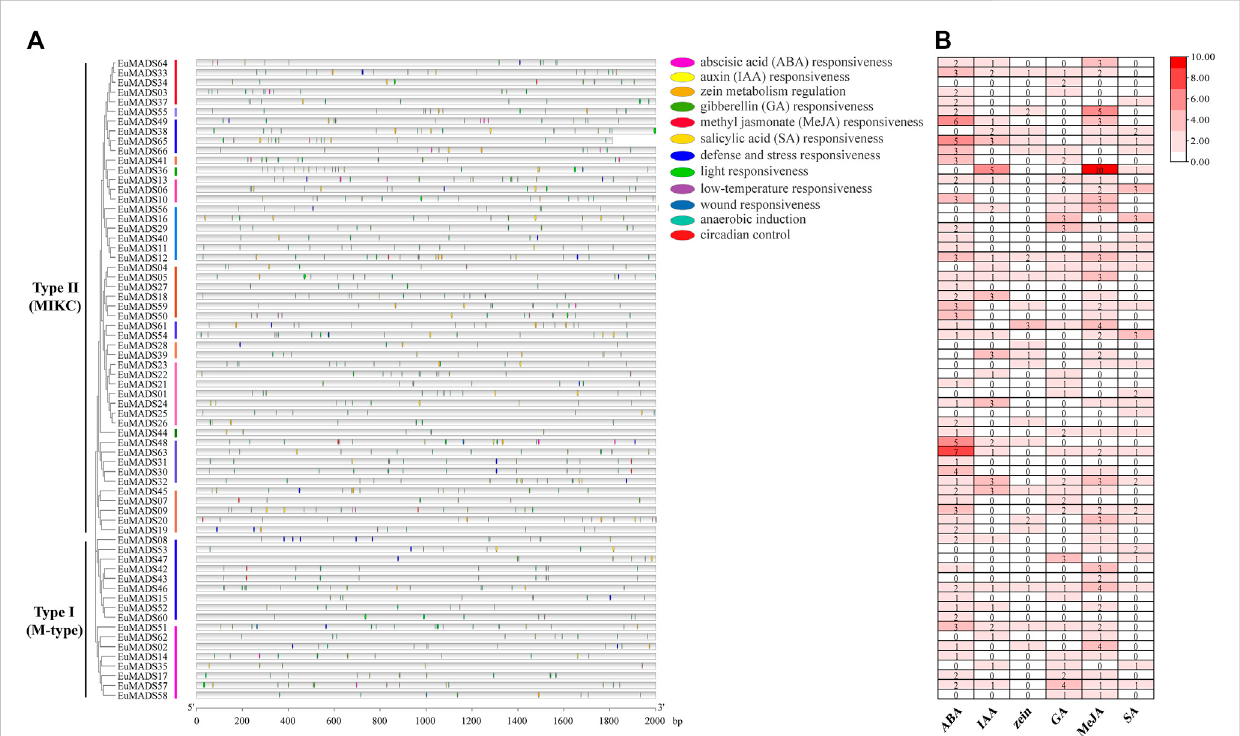
FIGURE 6 Predicted cis -acting regulatory elements for EuMADS genes. (A) The physical locations of cis -elements in the promoter region of each EuMADS gene,arrangedbythephylogenetictree.The12functionalmodulesareshownascoloredellipse boxes. (B) Countsofphytohormone(ABA,IAA,zein,GA, MeJA, and SA) response cis -elements in each EuMADS